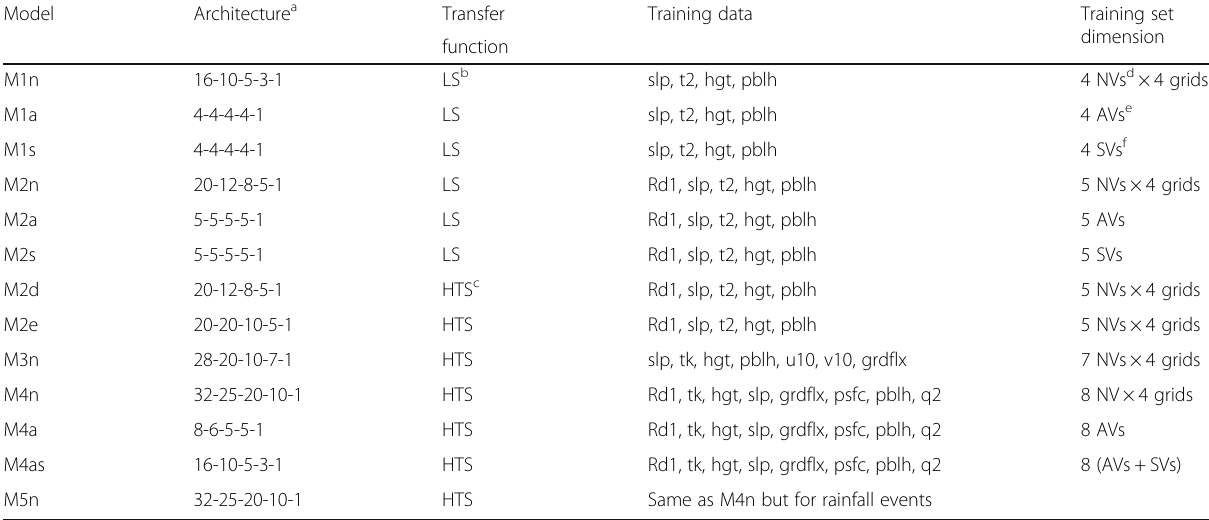
Table 3 Distinctive ANN models considered in the preliminary